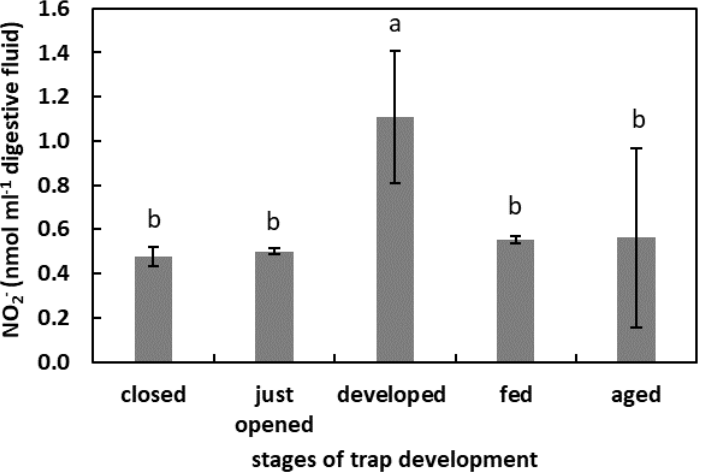
Figure 6. The NO 2 − concentration in digestive fluid in the traps at the different developmental stages: closed, just opened, developed, fed (one day after feeding), and aged. Values are average ± SD of 3 repetitions. Letters ( a , b ) indicate homogenous groups determined after ANOVA and post hoc Fisher ’ s LSD test at p ≤ 0.05.